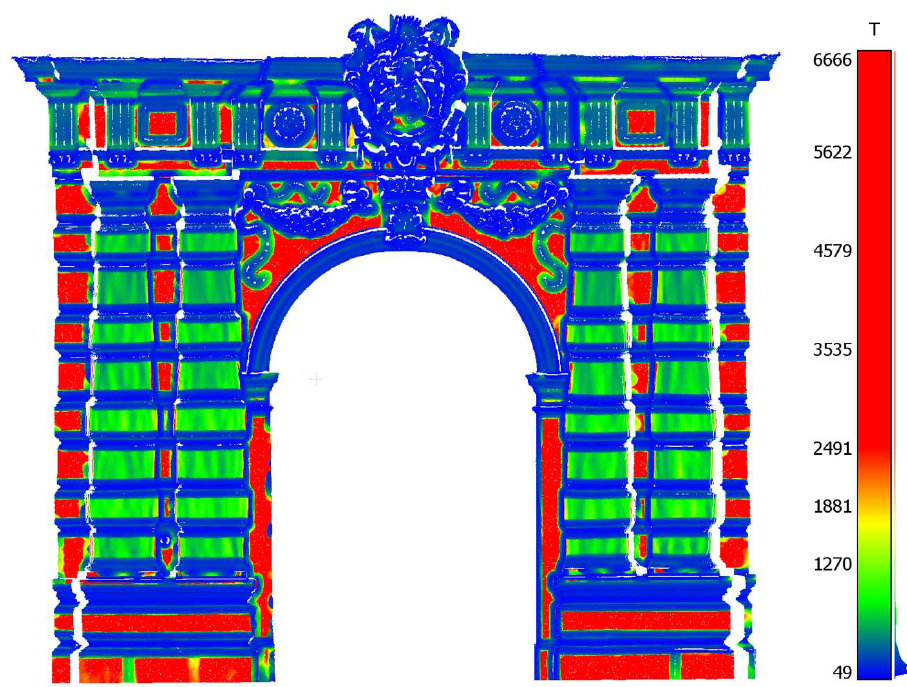
Figure 10. Data 3—original point cloud colored according to the T values; red—flattest parts, blue—most curved/rugged parts.